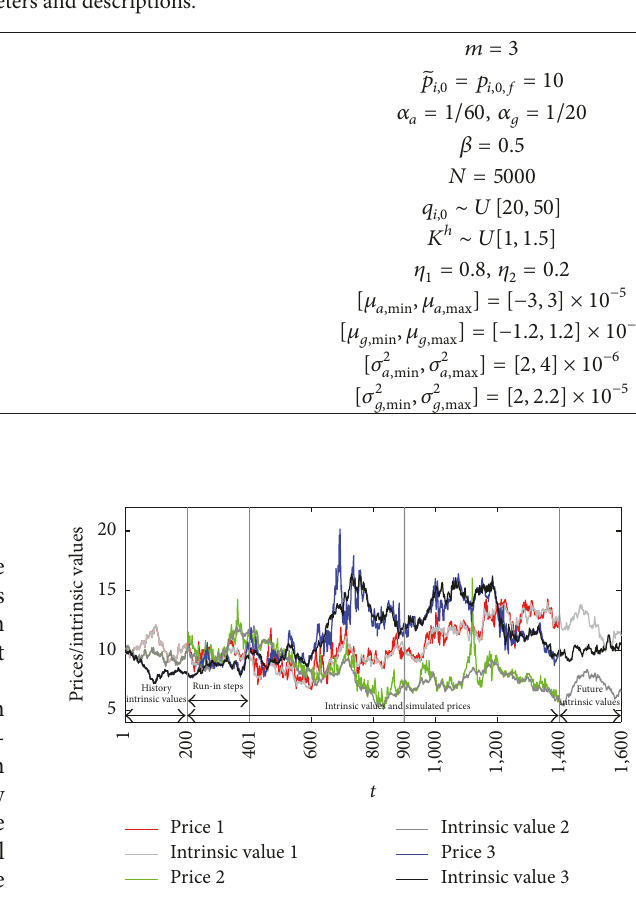
Figure 1: Intrinsic values and simulated prices of